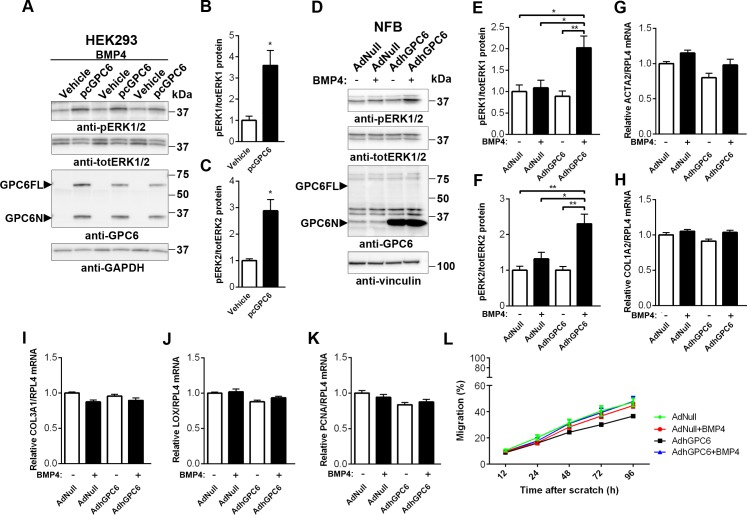
Glypican-6 enhances BMP4-dependent ERK1/2 signaling in cultured cardiac fibroblasts.Representative immunoblots and quantification of phospho-extracellular signal-regulated kinase (ERK)1 (pERK 44) relative to total ERK1 (totERK 44; Mw ≈44 kDa) and phospho-ERK2 (pERK 42) relative to total ERK2 (totERK 42; Mw ≈42 kDa) in bone morphogenetic factor (BMP)4-treated human endothelial kidney (HEK)293 cells transfected with a plasmid encoding human GPC6 (pcGPC6) or vehicle (A-C), n = 3. Glyceraldehyde 3-phosphate dehydrogenase (GAPDH) was used as loading control. Representative immunoblots and quantification of pERK/totERK1 and 2 in BMP4- and non-treated rat cardiac neonatal fibroblasts (NFB), transduced with an adenovirus encoding human GPC6 (AdhGPC6) or empty vector (AdNull; D-F), n = 4. Vinculin was used as loading control. Immunoblots in A and D were run under reducing conditions (+dithiothreitol) revealing the unbound N-terminal domain of GPC6 (GPC6N; Mw ≈35kDa). The full length GPC6 (GPC6FL; Mw ≈62kDa) band represents non-glycanated GPC6 where N- and C-terminal domains are held together by disulfide bonds. Relative mRNA levels of α-smooth muscle actin (ACTA2; G), collagen I (COL1A2; H), collagen III (COL3A1; I), lysyl oxidase (LOX; J) and proliferating cell nuclear antigen (PCNA; K) normalized ribosomal protein L4 (RPL4) in BMP4- and non-treated NFB, transduced with AdhGPC6 or empty vector, n = 6–9 from three separate cell cultures. Migration (%) of BMP4- and non-treated NFB transduced with AdhGPC6 or empty vector, 12–96 h after scratch (L), n = 1–3 images of n = 3–6 wells per condition. Data are presented as mean ± S.E.M. Unpaired Student’s t-test (B, C) and one-way ANOVA with Bonferroni post-hoc test (E-L) were used to test for statistical significance. *P<0.05; **P<0.01; group significantly different from vehicle-transfected control, empty vector control or non-stimulated control.